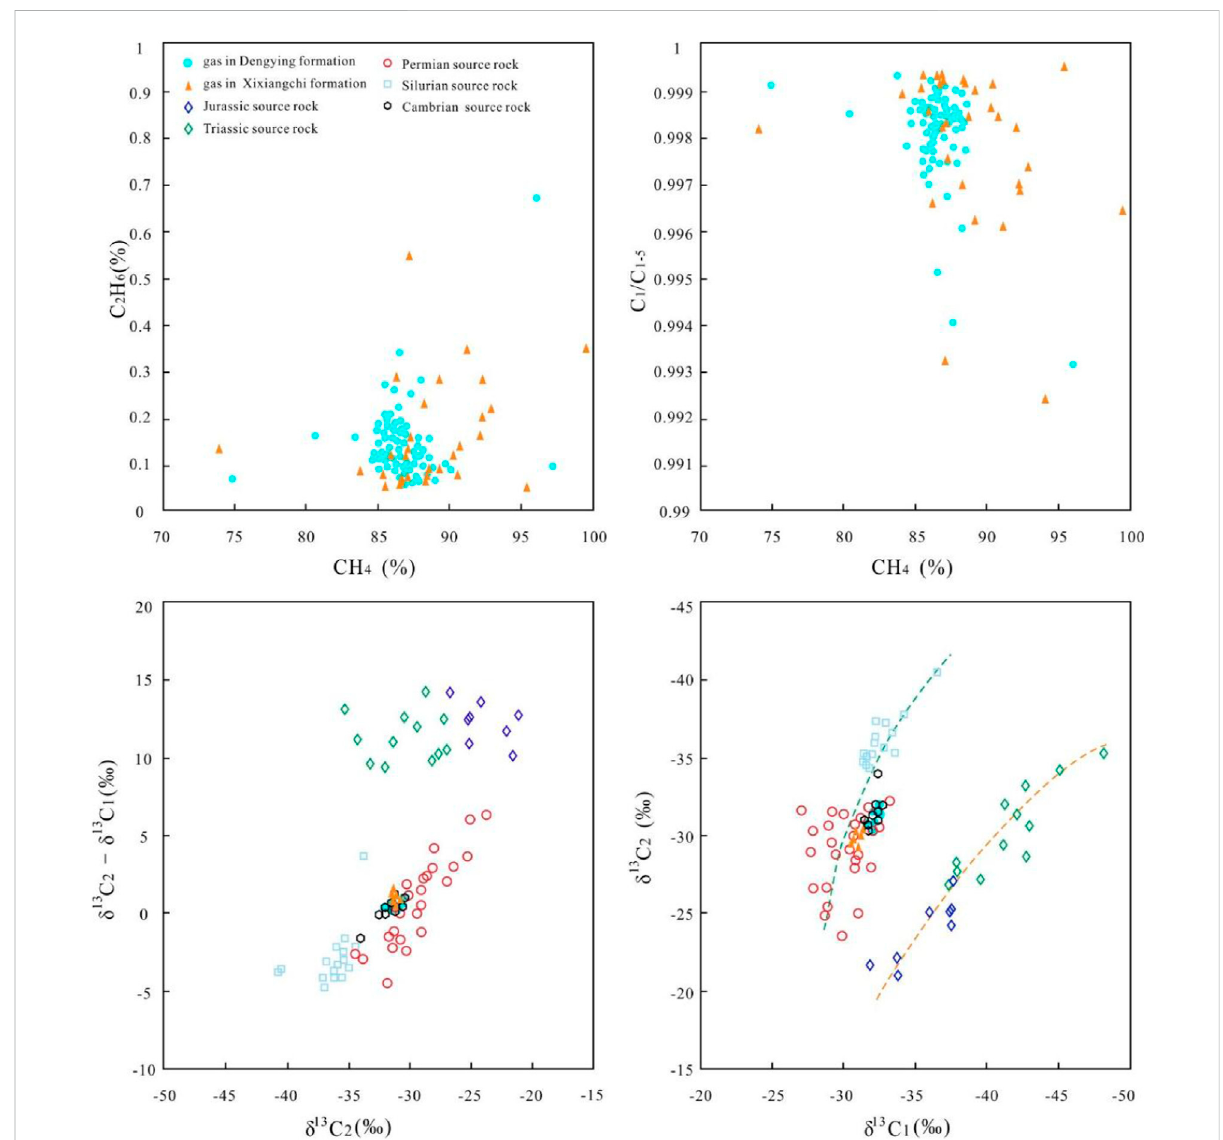
FIGURE 7 Characteristic diagram of natural gas component. (A) The relationship between methane content and ethane content; (B) The relationship between methane content and drying coef fi cient; (C) Carbon isotopic relationship between ethane and ( δ 13 C 2 - δ 13 C 1 ); (D) Carbon isotopic relationship between methane and